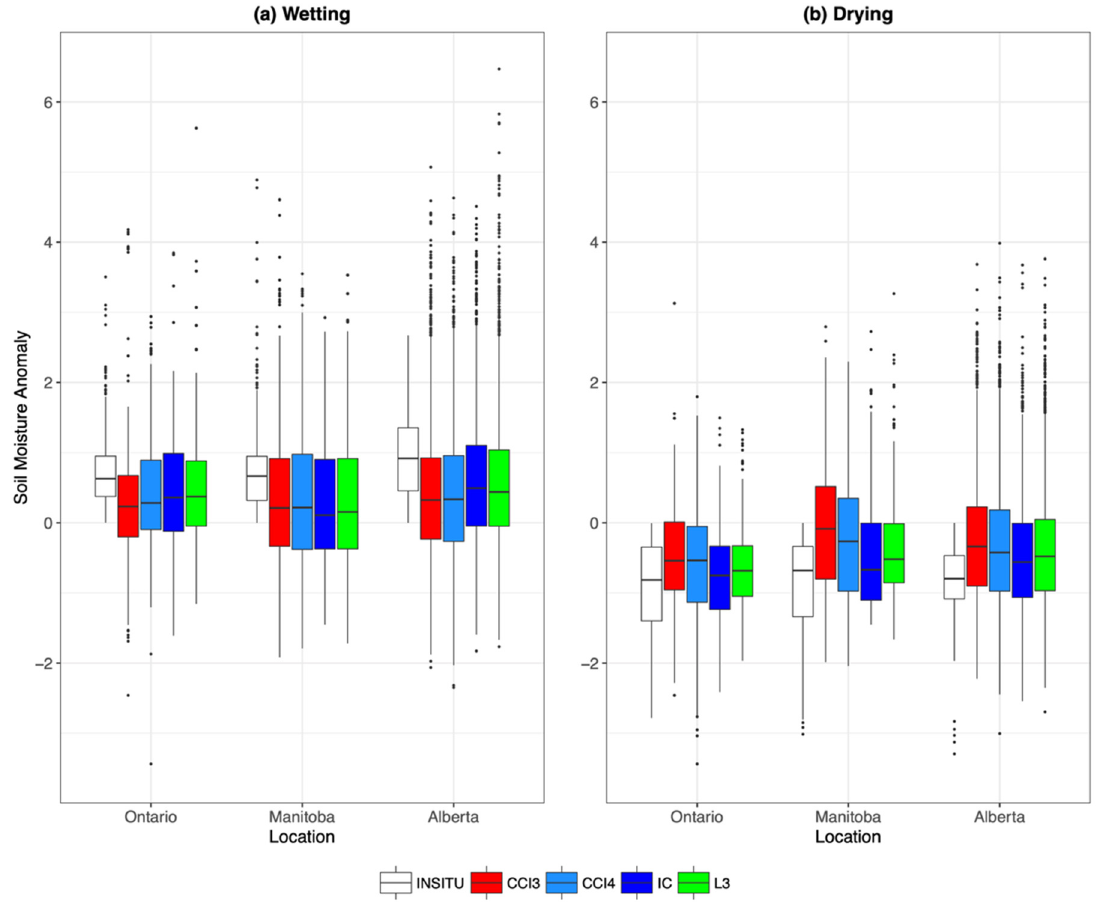
Figure 5. Boxplots of standardized SM anomalies for in situ, CCI3, CCI4, IC and L3 over May to October for a three-year evaluation period (2012–2014) at Ontario, Manitoba and Alberta networks. The figure shows SM anomalies for each satellite product binned by the sign of the in situ anomaly: ( a ) positive (wetting) and ( b ) negative (drying). For each network, the boxplots are constructed from a pool of all daily SM anomalies for all stations within that network, for only those days when data are available for all products at a given in situ location.